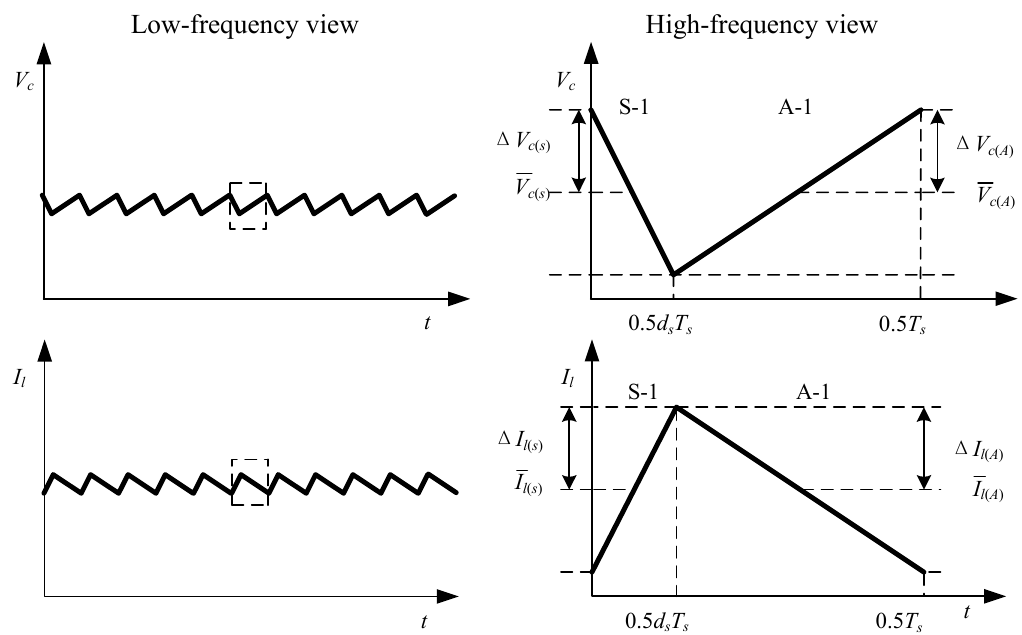
Figure 4. Waveforms of capacitor voltage and inductor current for high-frequency ripple